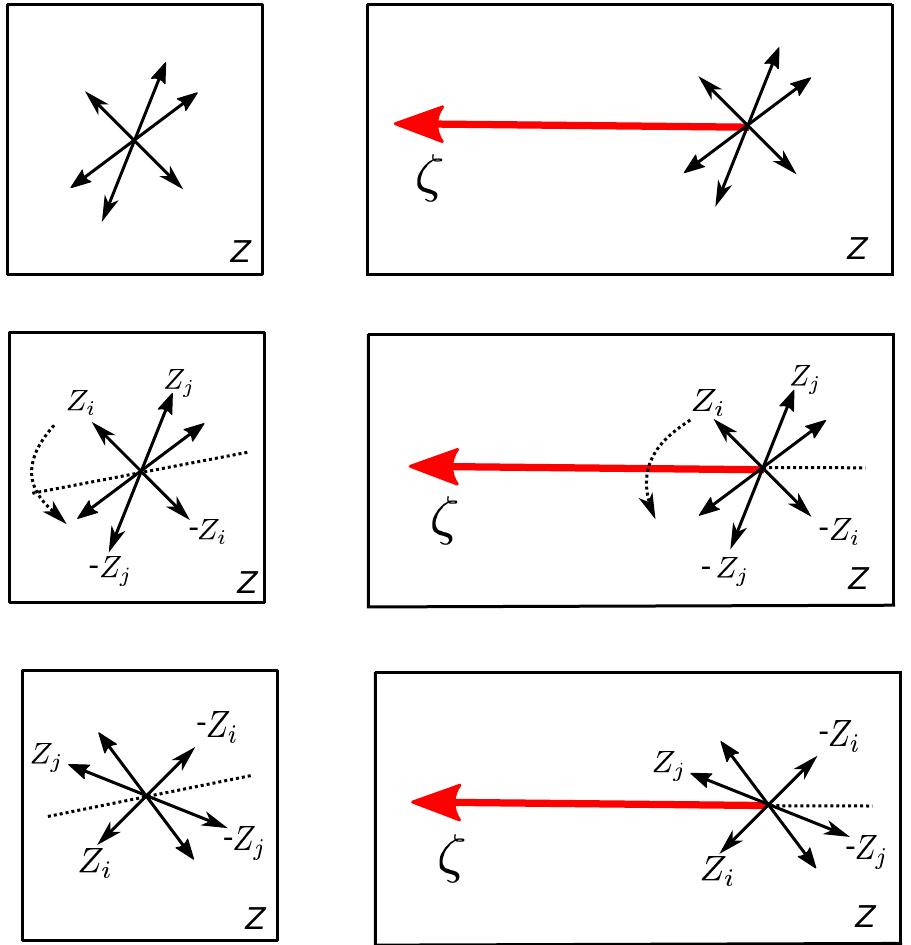
Figure 3 . Quiver mutation VS framed quiver mutation. up left: mapping a BPS spectrum to the Z -plane. up right: BPS spectrum in the Z -plane in presence of a BPS line defect with phase ζ . mid left: choice of a quiver basis, splitting among particles and anti-particles. mid right: our choice of conventions: anti-walls and walls of the second kind coincide. down left: rotating the Z -plane or equivalently changing convention about the particle/antiparticle splitting thus leading to a quiver mutation. down right: framed BPS quiver mutation: the Z i rotate, while ζ is held fixed. Notice that this implies also a framed BPS